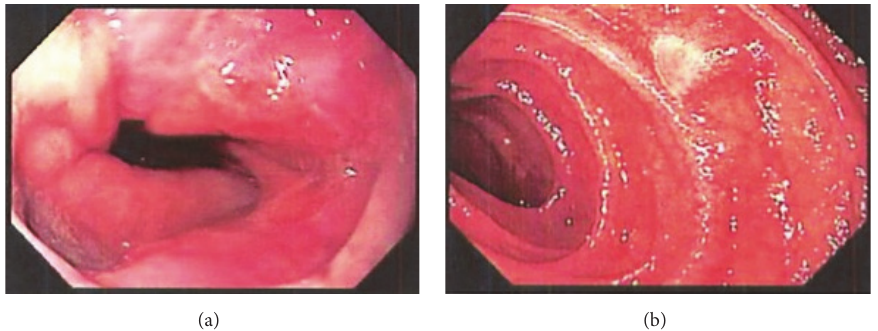
Figure 1: (a) Esophagogastroduodenoscopy (EGD) with squamocolumnar junction at 40cm and evidence of esophagitis. (b) Esophagogas- troduodenoscopy (EGD) showing scattered flat polypoidal lesions in the distal duodenum.